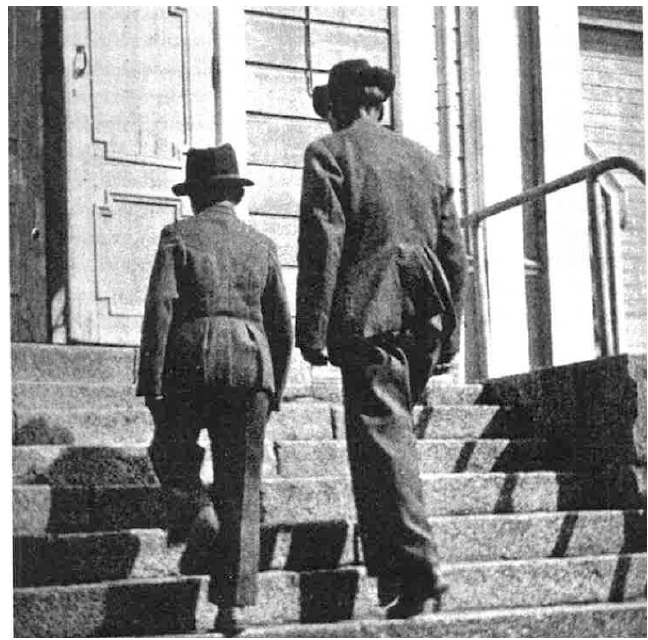
Figure 1. The male körtti dress with distinctive ‘skirts’, ‘körtit’. Photograph: Wilhelmi Malmivaara